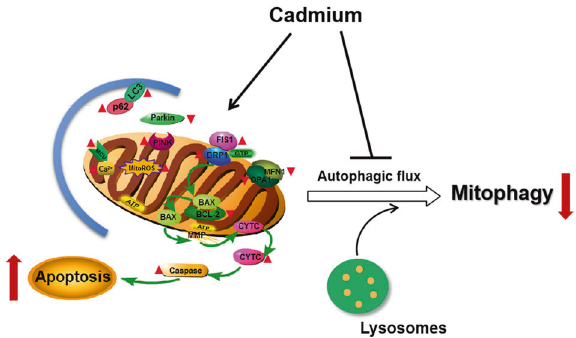
Fig. 9 Schematic illustration of cadmium-induced toxicity in TM3 cells. Cadmium causes mitochondrial dysfunction and promotes excessive mitochondrial fi ssion by controlling the expression of mitochondrial dynamics regulatory proteins (DRP1, FIS1, MFN1 and OPA1). Consequently, cytochrome c is released from the mitochon- dria to cytosol and the mitochondria-dependent intrinsic apoptosis of TM3 cells is induced. Moreover, cadmium probably disrupts calcium homeostasis and inhibits autophagic fl ux in the cells. The blocking of Parkin recruitment into damaged mitochondria by cadmium results in inhibition of mitophagy, production of excessive ROS and cell